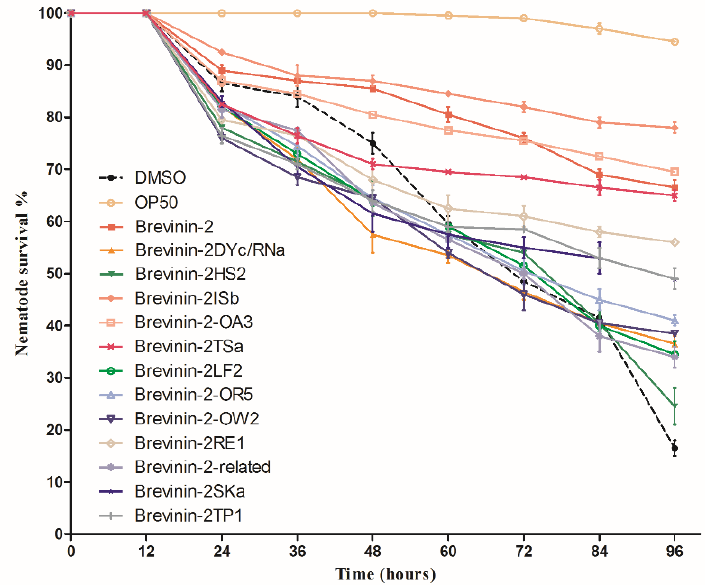
Figure Figure 4. The survival of MRSA-infected C. elegans assessed by liquid-based assay using Brevinin-2 family peptides.